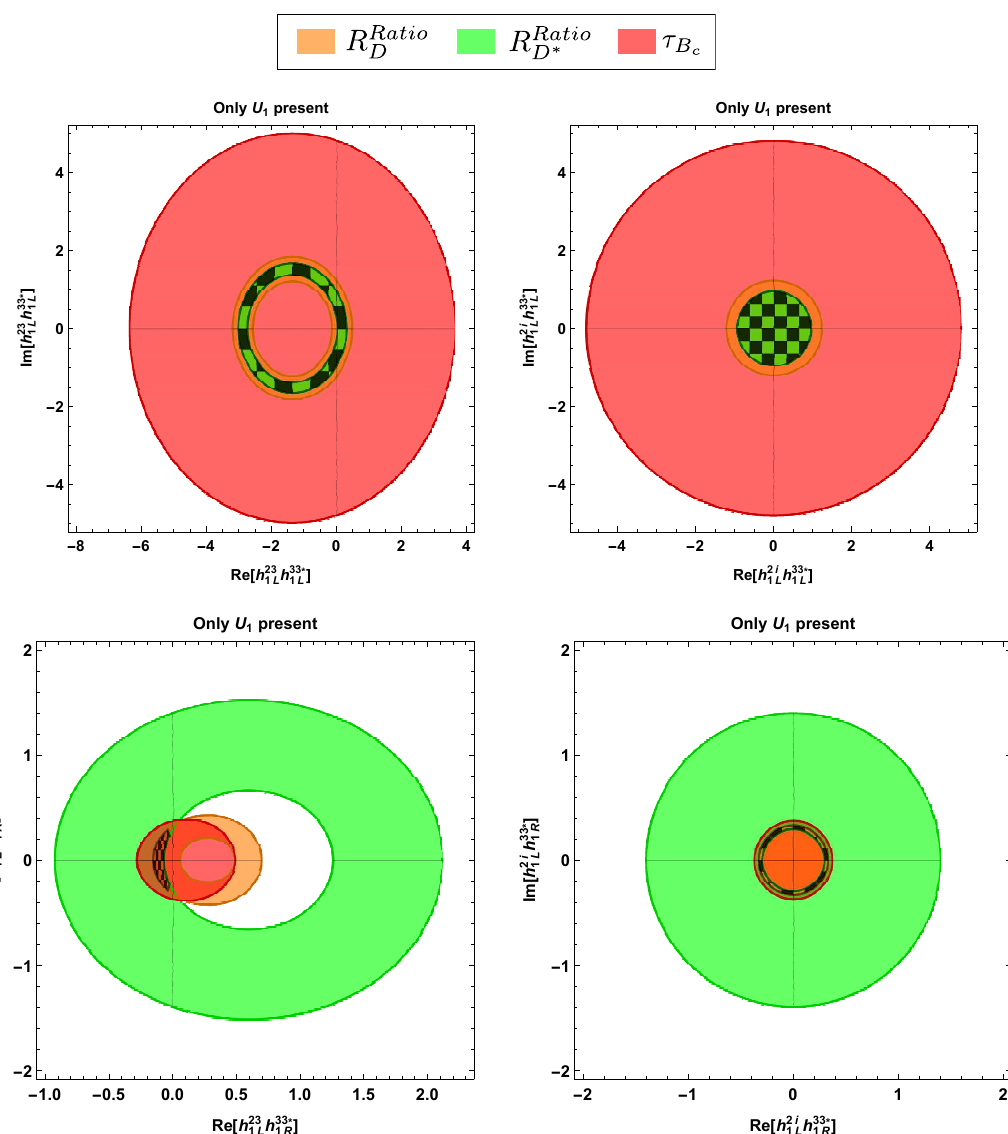
Figure 8 . Constraints on the U 1 leptoquark model when considering one coupling at a time. Here, i = 1 , 2 denotes the electron and muon neutrinos. We require that the couplings reproduce the measurements of R Ratio and R Ratio in eqs. (1.7) and (1.8) within 3 σ and satisfy D D ∗ 30%. The allowed regions of the parameter space when combining all constraints are highlighted with a black